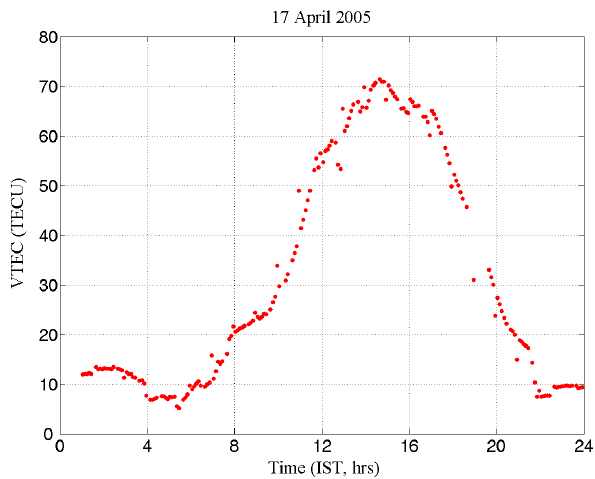
Fig. 1. Diurnal variation of TEC observed for a ± 2 ◦ latitude and ± 2 ◦ longitude bin from the observing station Rajkot (22.29 ◦ N, 70.74 ◦ E, 14.29 ◦ N